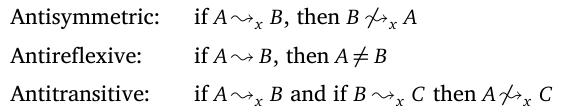
Characteristics of